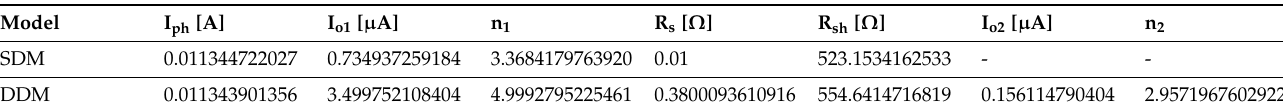
Table 4. The parameters of aSi photovoltaic cell.